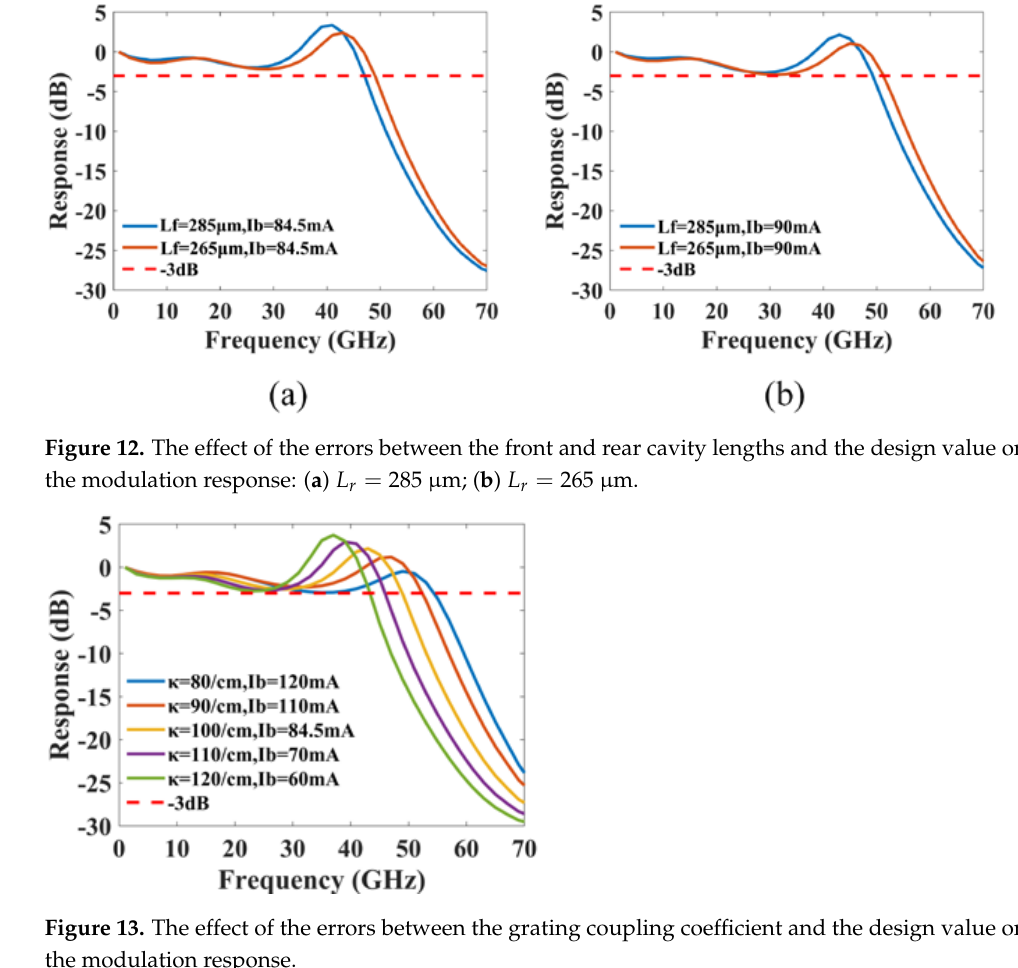
Figure 13. The effect of the errors between the grating coupling coefficient and the design value on the modulation response.